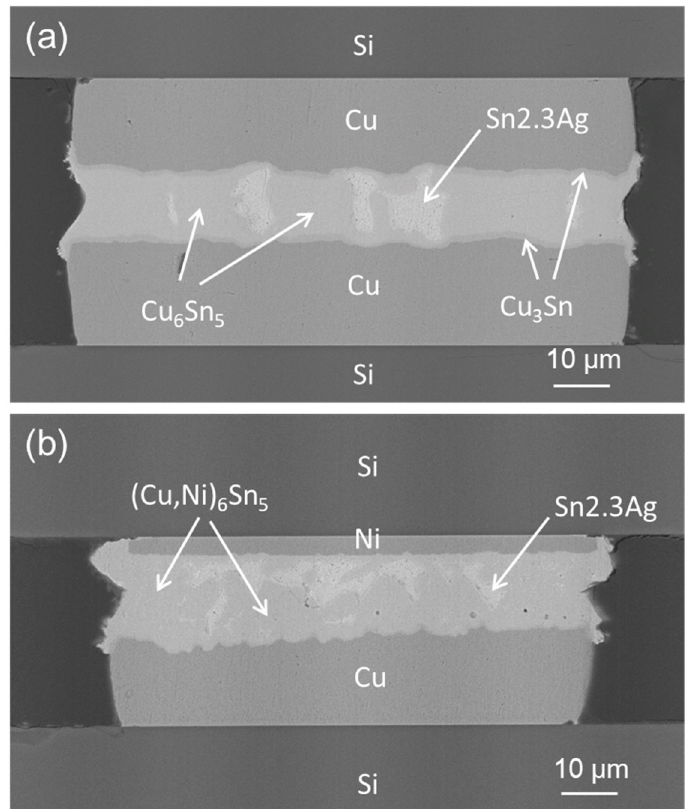
Figure 5. Cross-sectional SEM BEIs of the fully IMC-bridging microbumps (reflowed for 30 min) after 2000 TCT cycles. ( a ) Cu/solder/Cu. ( b ) Ni/solder/Cu. Arrows designate the IMCs.